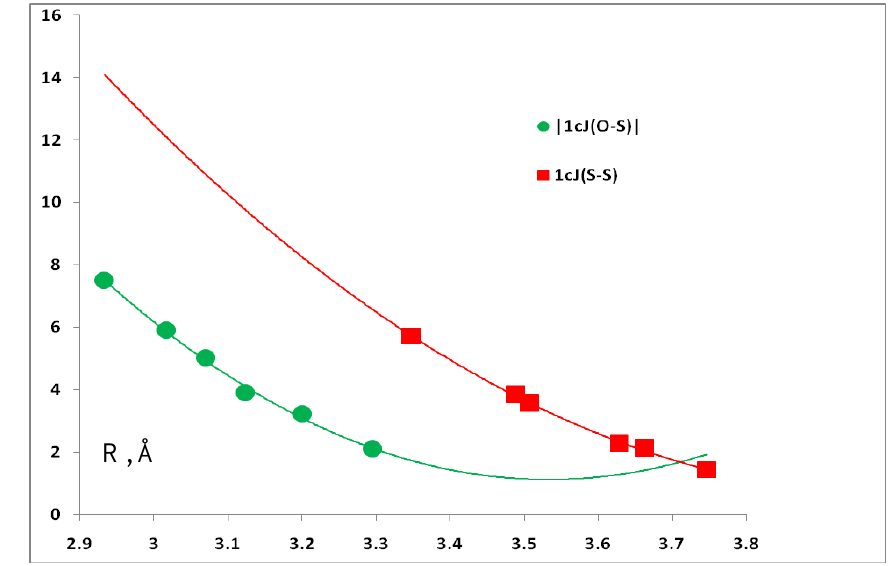
Figure 5. Coupling constants 1c J(S – S) for the HN(CH)SX:SCO complexes and the absolute values of 1c J(O – S) for the HN(CH)SX:OCS complexes versus the S – S and O – S distances, respectively.